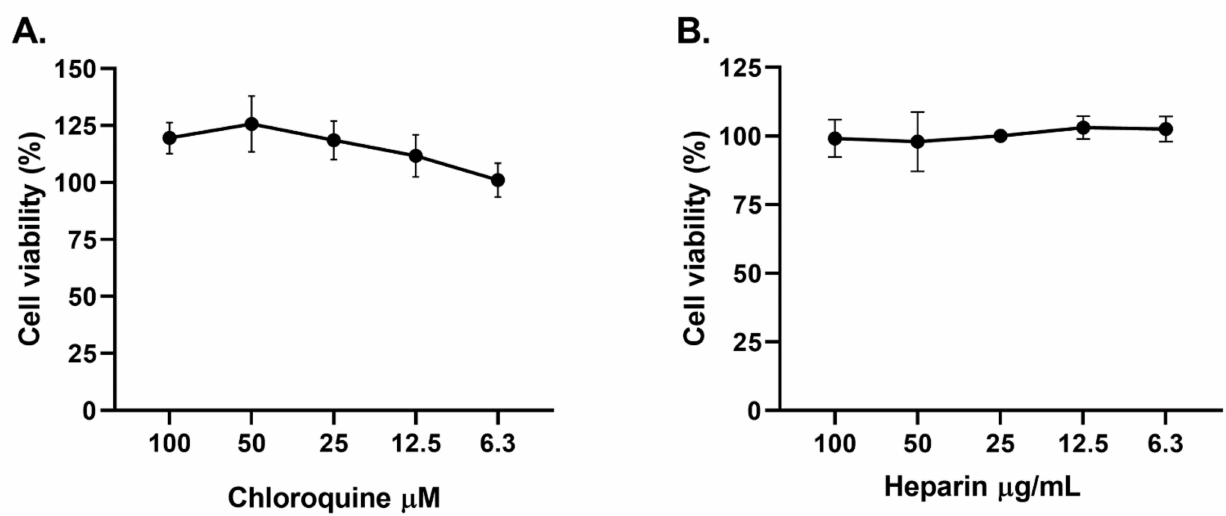
Figure 2. Positive controls of viral inhibition showed low cytotoxicity on Vero E6. The figure represents the viability percentage of Vero E6 cells after 48 h of treatment with ( A ) CQ (6.3–100 µ M) and ( B ) heparin (6.3–100 µ g/mL). Bars represent mean values ± SEM. Two independent experiments with four replicates each experiment was performed (n =